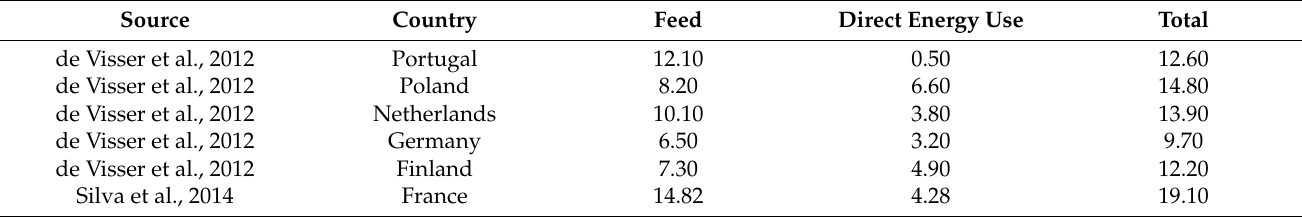
Table A4. Energy inputs for broiler production MJ/kg (based on